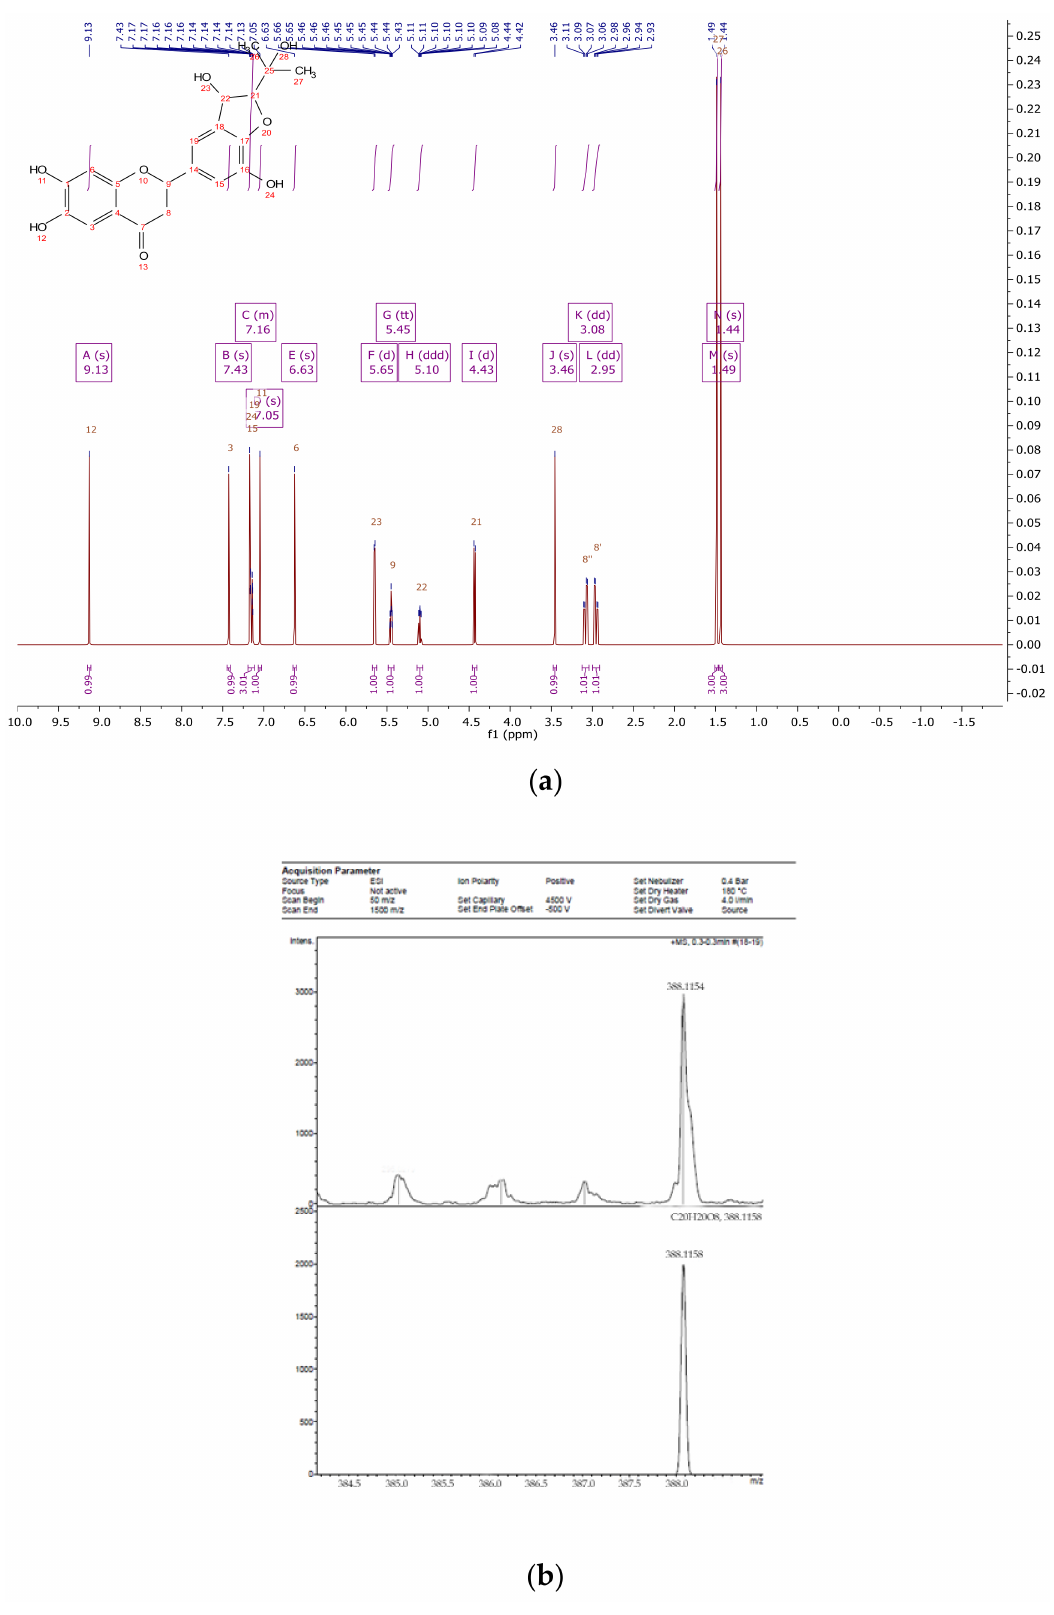
Figure 3. 1 H NMR ( a ) and HRMS ( b ) spectrum of 2-(3,7-dihydroxy-2-(2-hydroxypropan-2-yl)-2,3-dihydrobenzofuran-5-yl)- 6,7-dihydroxychroman-4-one from extracts of callus, cell suspension, and root cultures of Rhodiola rosea